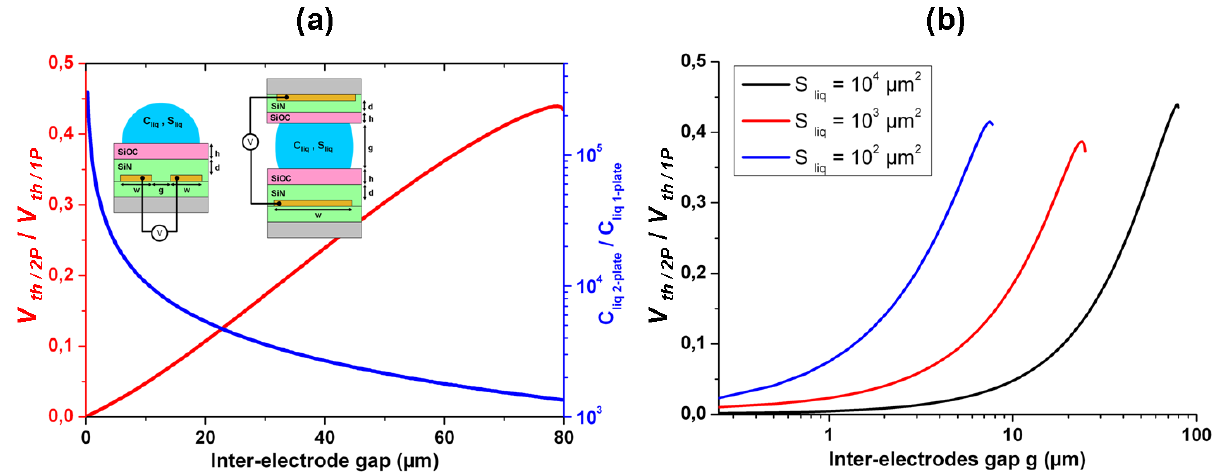
f = 10f for an ultra pure water ( σ = 6 × 10 −5 S m −1 , ε = 80) liquid finger actuation with c liq liq a liquid cross-section area S =10 4 µm 2 and with 100 nm thick SiN layer and 100 nm thick liq SiOC layer. (b) Graph illustrating the threshold voltage actuation ratio between the two-plates and the single-plate device as a function of the inter-electrode gap for several liquid cross-sections considered. Calculations are made at f = 10f for an ultra pure water c liquid finger actuation and with 100 nm thick SiN and 100 nm thick